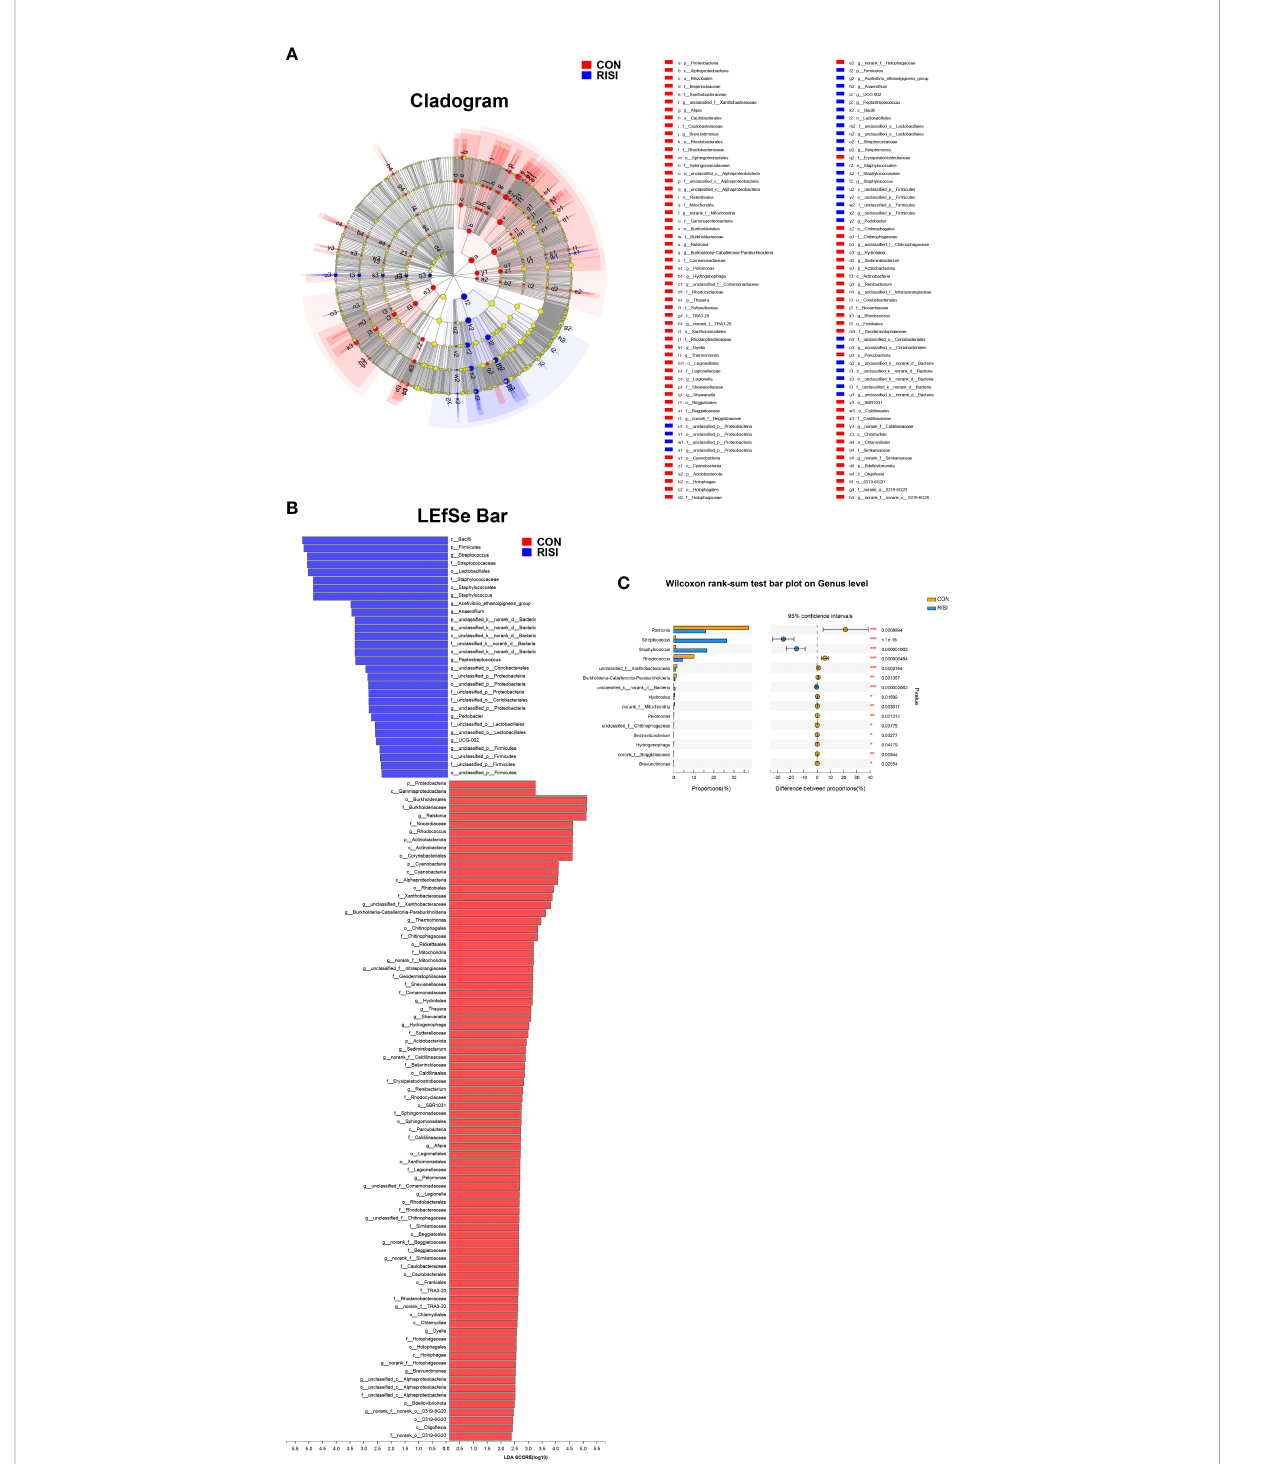
FIGURE 3 Results of linear discriminant analysis (LDA) effect size (LEfSe). (A) Hierarchical tree map of multilevel species. (B) LDA histogram showing the microbial groups that play signi fi cant roles in several groups. The LDA scores obtained by linear regression analysis showed that the higher the score, the greater the effect of species abundance on the difference. (C) Relative abundance of the most predominant genera in cutaneous microbiomes of radiation-induced skin injury (RISI) and healthy